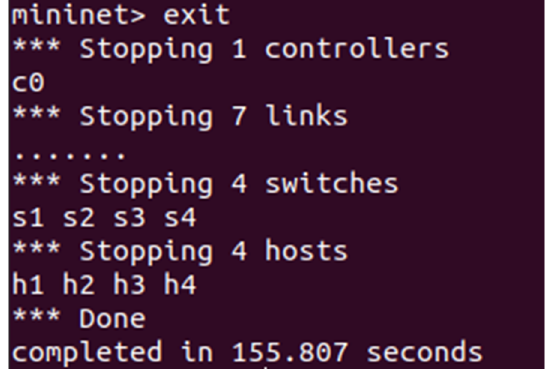
Figure 28. Linear topology: time to complete the procedure from start to finish with ODL controller.